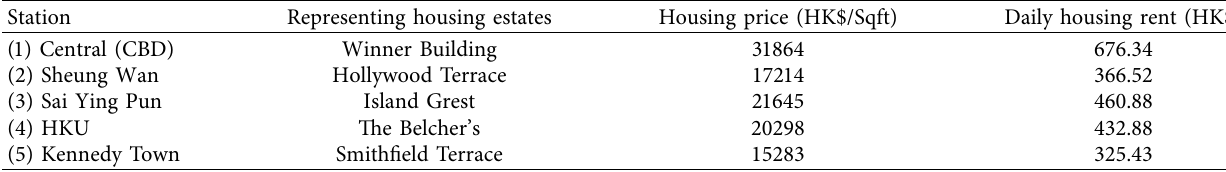
Table 3: The housing rent list along the Western Island Line.